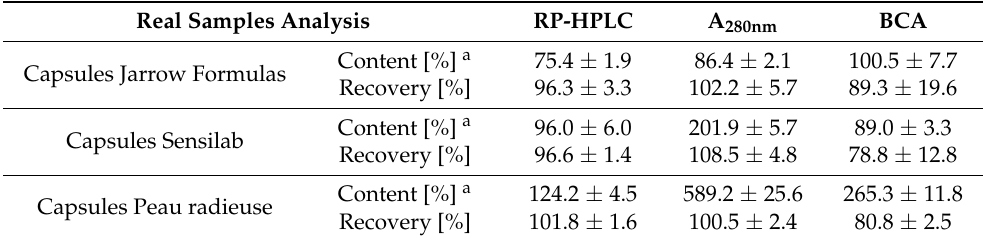
Table 5. Analysis of samples containing lactoferrin.